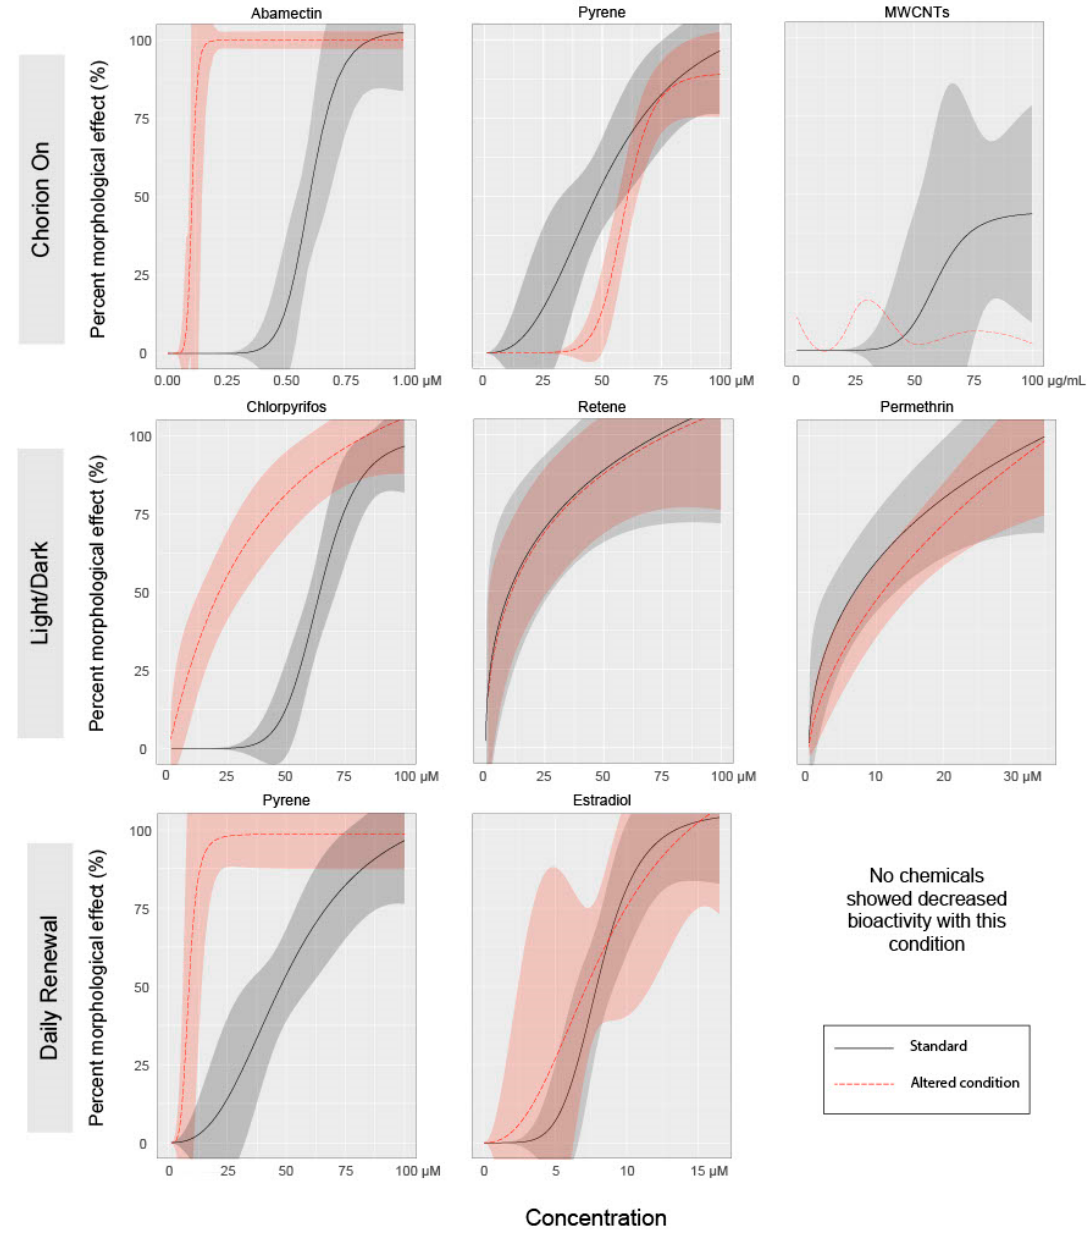
Figure 3. Dose–response curves for select test agents for each condition. Individual figures were selected to display the range of effects on bioactivity of each condition versus the standard regimen. Lines represent mean percent incidence for each concentration fit to a logarithmic regression model. Shaded areas represent 95% confidence intervals for model fit. MWCNT chorion-on exposure did not produce effects great enough to which to fit a logarithmic model. For this instance, a LOESS model was fit to the mean percent incidence values for each concentration.